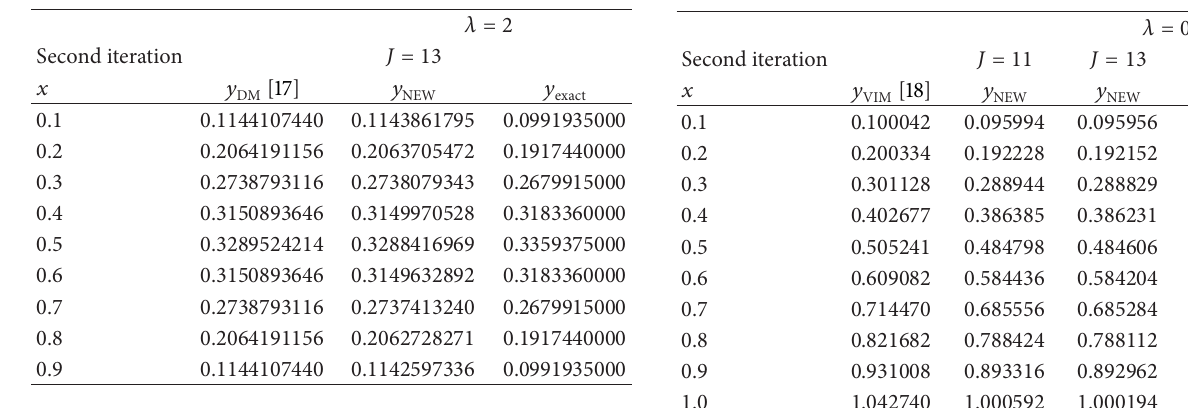
Table 4: Comparison of exact solution 𝑦 , solution by variational exact , and solutions by the wavelet-Galerkin iteration method 𝑦 VIM at second iteration, method with quasilinearization technique 𝑦 NEW at different level of resolutions, and we used 𝐷8 as Galerkin